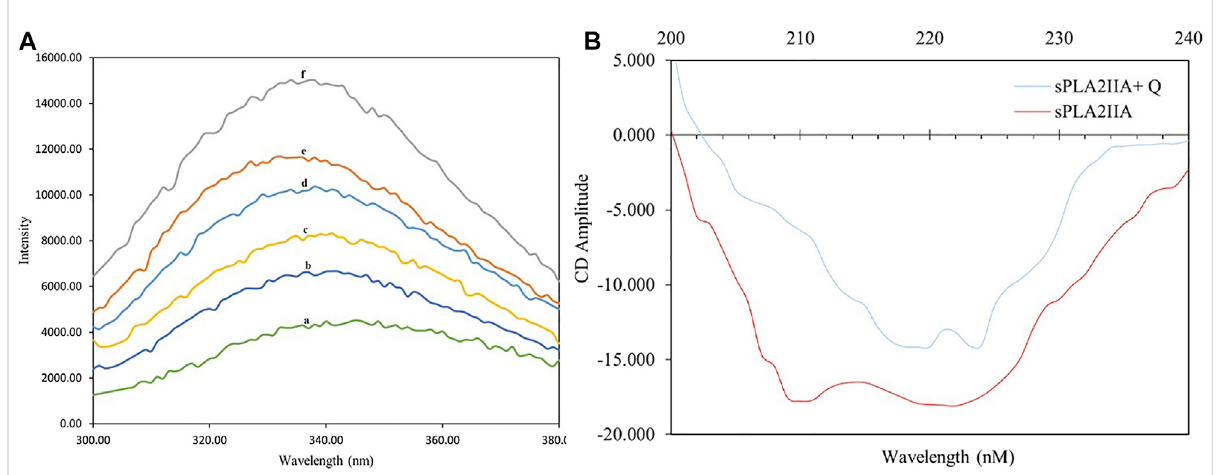
FIGURE 4 Intrinsic fl uorescence and circular dichroism studies. (A) Intrinsic fl uorescence spectra of sPLA 2 IIa enzyme (a) , sPLA 2 IIa enzyme with quercitrin of 0.02 µM (b) , 0.04 µM (c) , 0.06 µM (d) , 0.08 µM (e) , and 0.1 µM (f) concentrations. (B) UV-CD spectra of sPLA 2 IIa enzyme with and without IC 50 concentration of quercitrin between 200 – 240 nm.